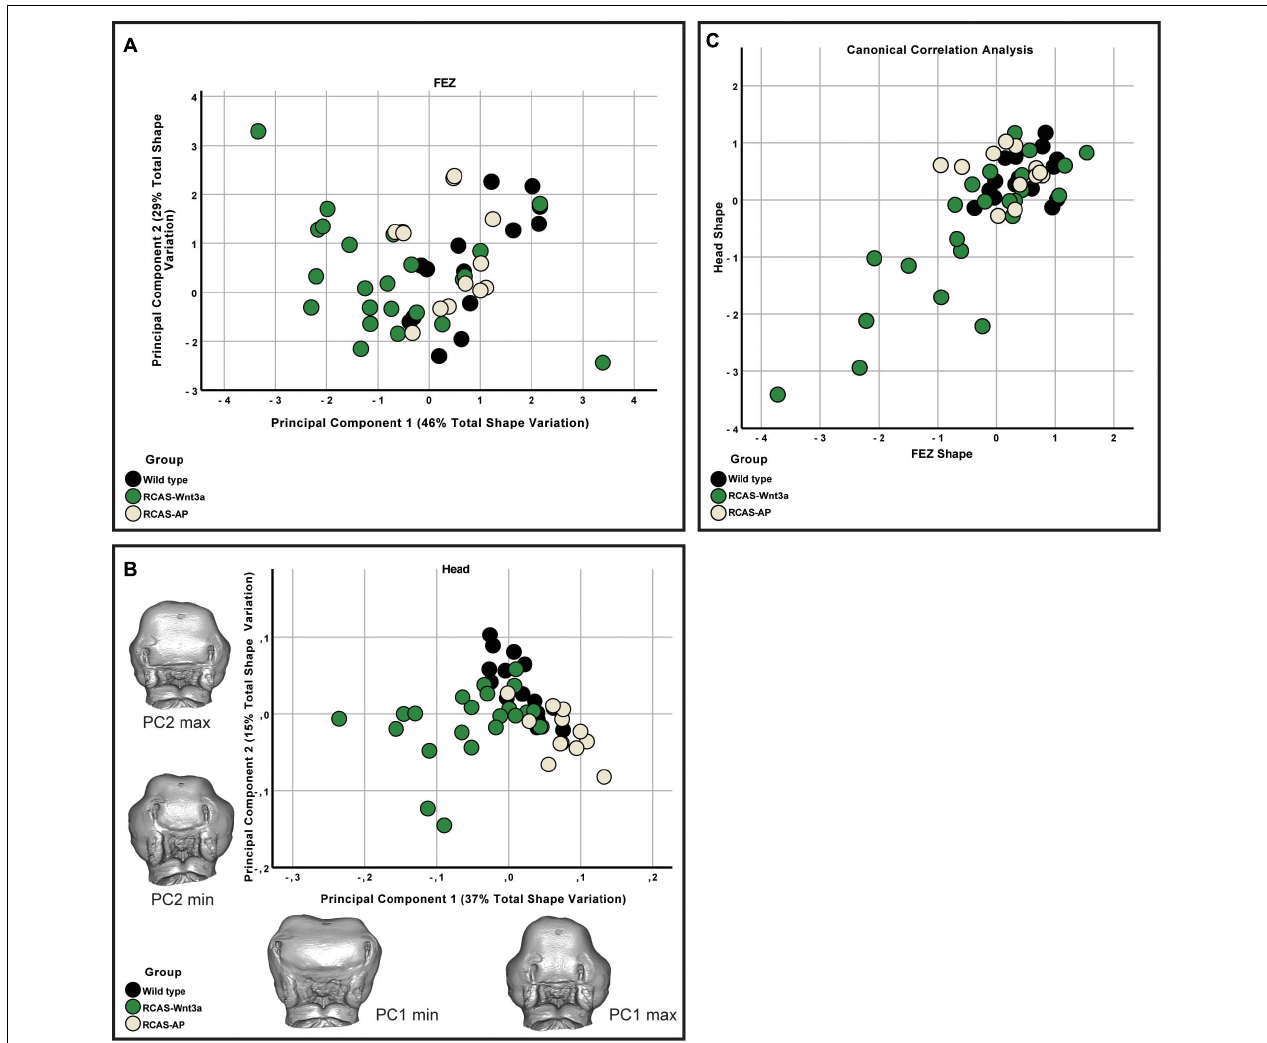
FIGURE 2 | FEZ and head shape variation between wild-type, RCAS-Ap and RCAS- Wnt3a at stage 22/23. (A) Biplot of first two principal components of FEZ shape based on four variables. (B) Biplot of first two principal components of head shape based on 21 landmarks. Gray meshes represent head shape at the extreme of the principal component. (C) Canonical correlation analysis of the first five principal components of the head and the four principal components of the FEZ.